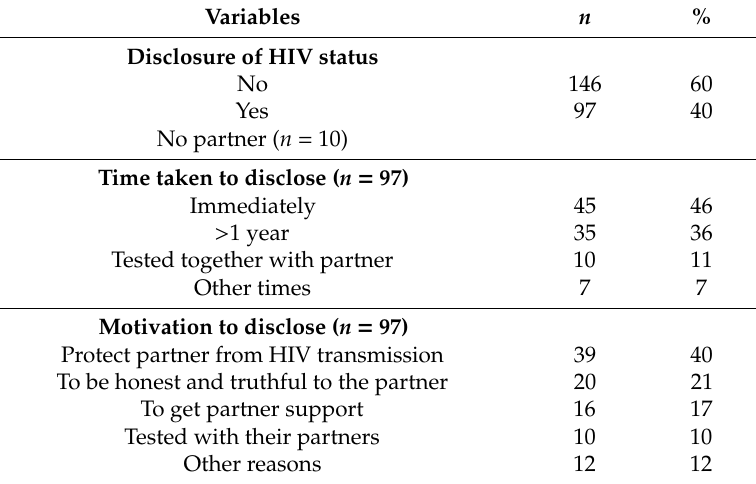
Table 4. Disclosure status and motivation to disclose to sexual